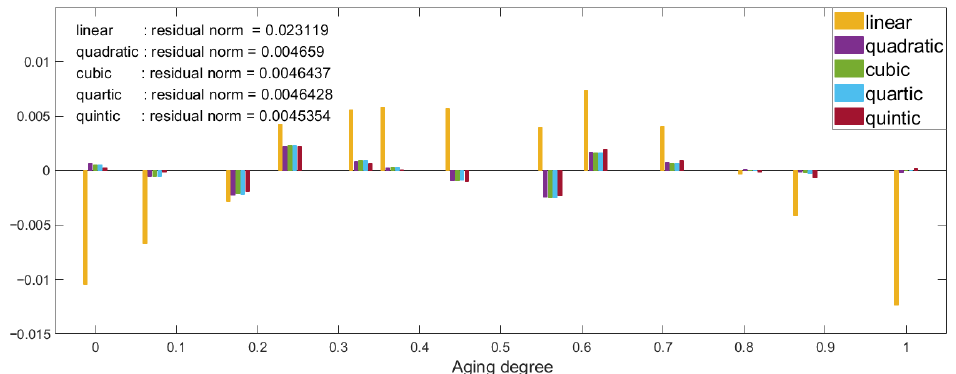
Figure 11. The residual error diagram of the fitting curve of the relationship between the aging degree of silicone rubber and the terahertz S11 parameter.